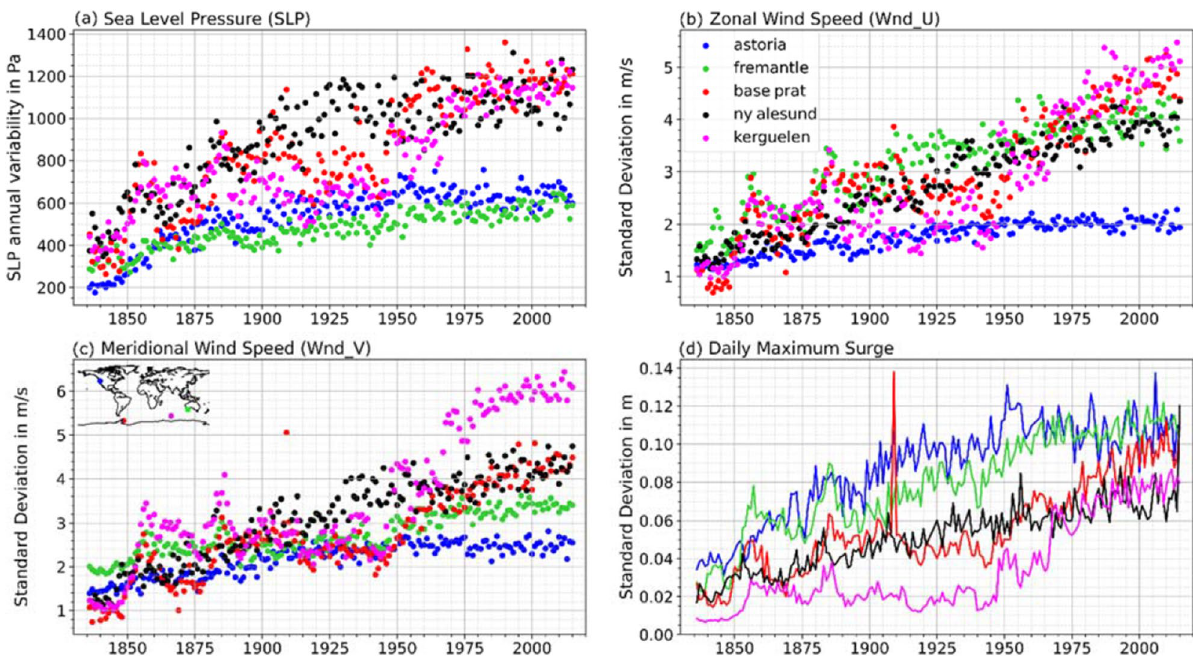
Figure 12. Decreasing variability (expressed as annual standard deviation) for 20CR predictors mean sea-level pressure ( a ), zonal wind speed ( b ), meridional wind speed ( c ), and G-20CR ( d ) for selected tide